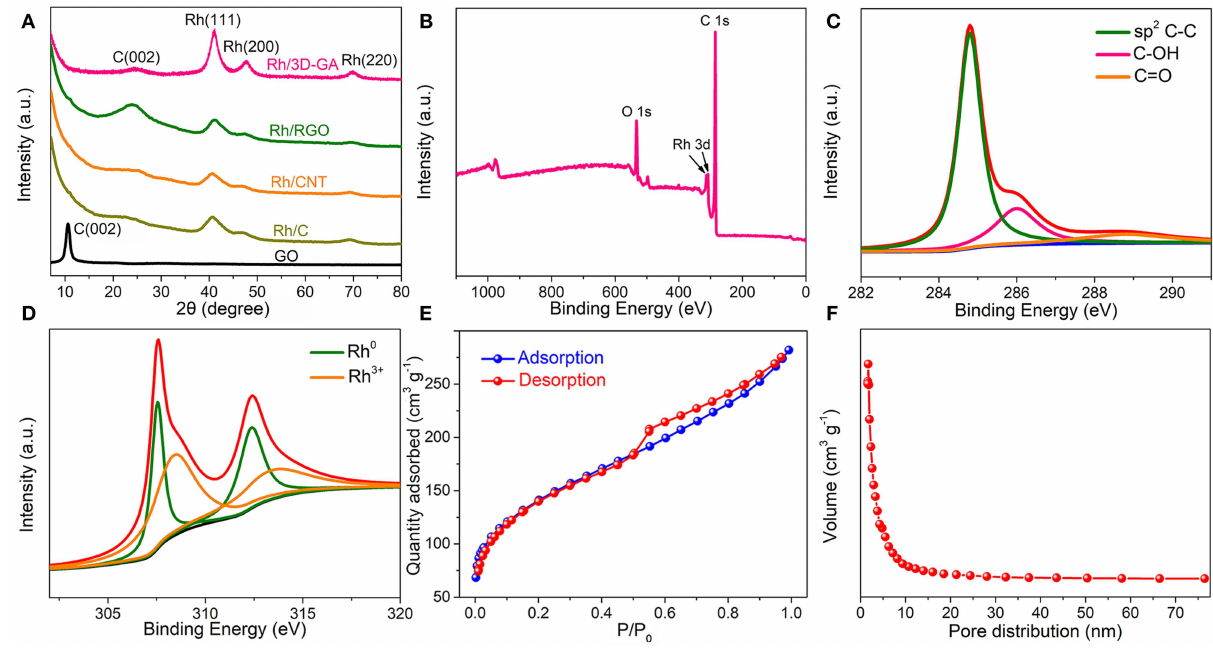
FIGURE 2 | (A) Typical XRD patterns of the Rh/3D-GA, Rh/RGO, Rh/CNT, Rh/C, and GO materials. (B) XPS survey, (C) C 1s, and (D) Rh 3d spectra of the Rh/3D-GA architecture. (E) Nitrogen adsorption–desorption isotherm and (F) pore size distribution of the Rh/3D-GA architecture. the working electrode surface was kept at 0.028 mg cm − 2